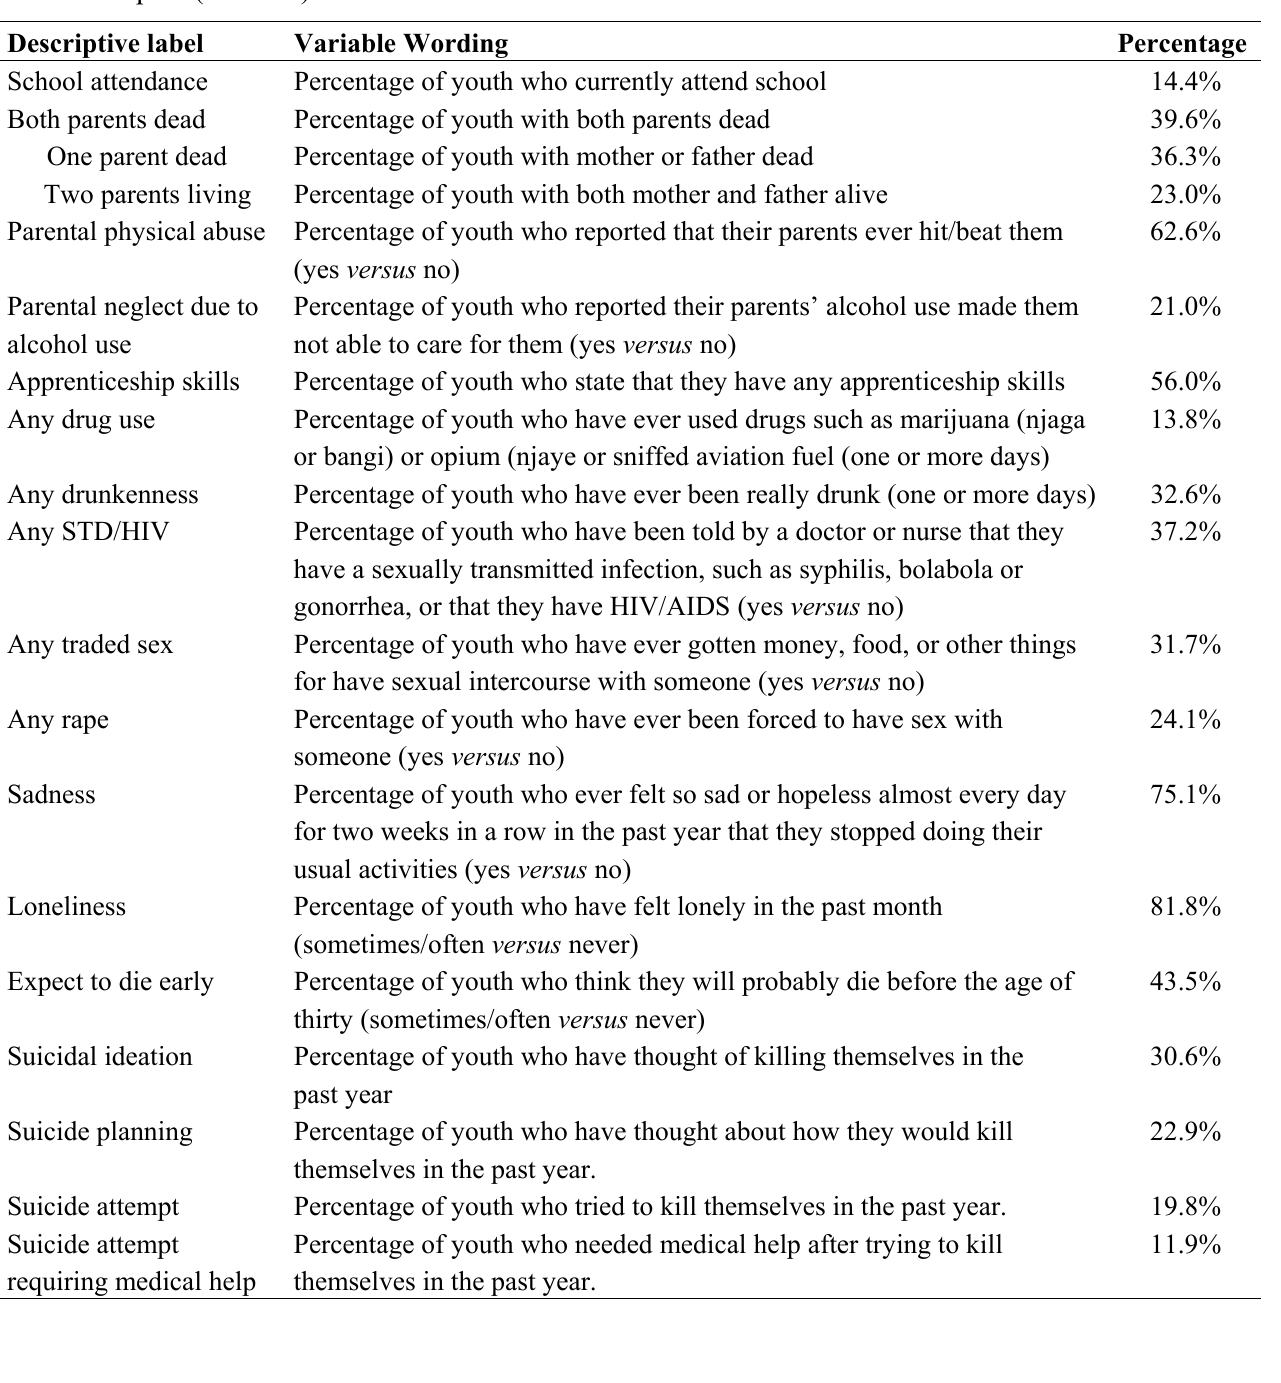
Table 1. Description of variables and their prevalence among youth living in the slums of Kampala ( N =